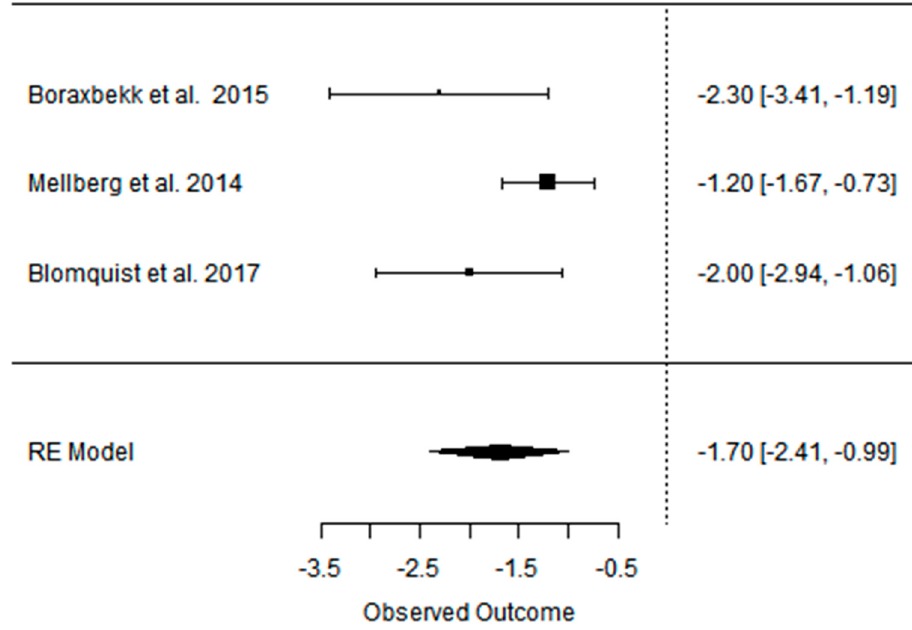
Figure A6. Forest plot of the effect of a CD on BMI in the short term (weighted mean difference).